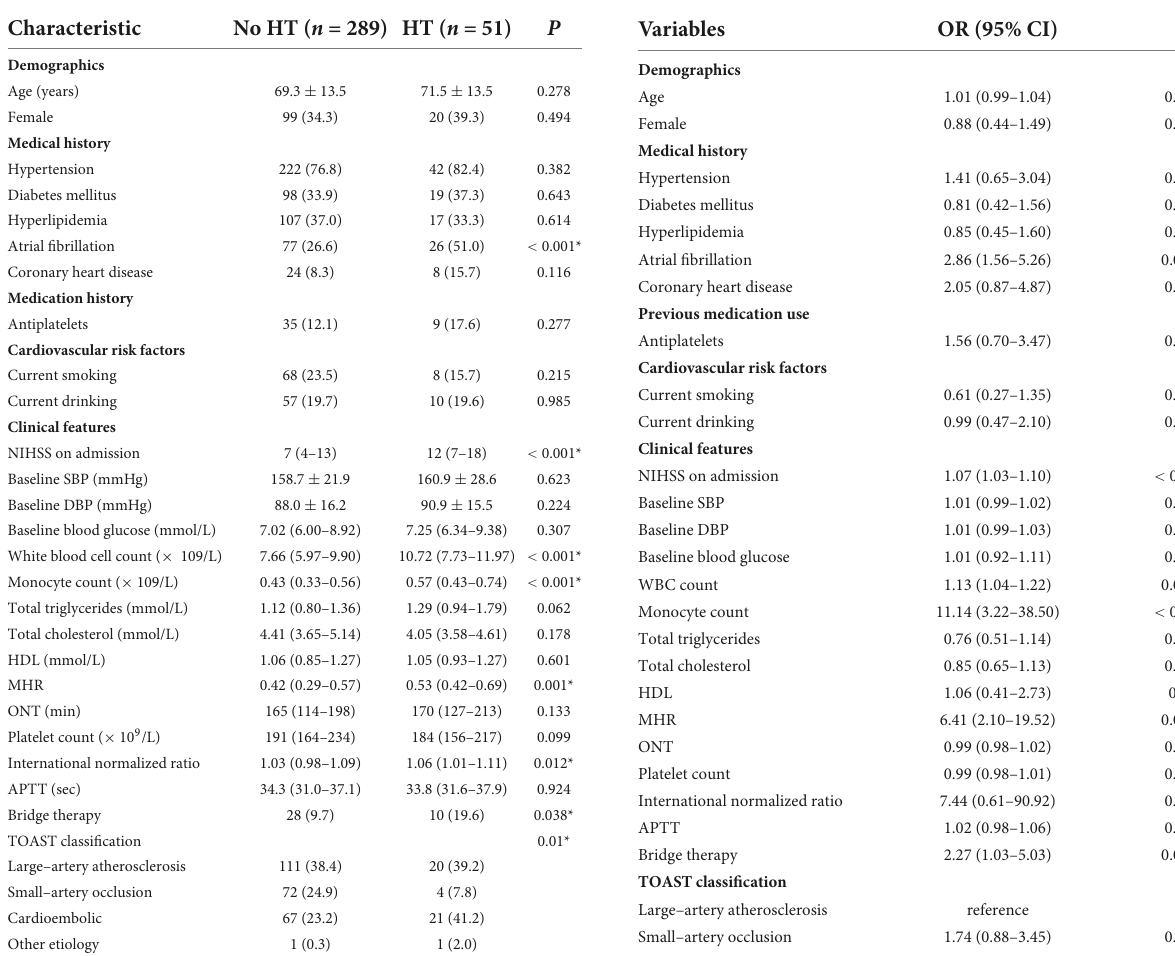
TABLE 3 Univariate logistic regression model for risk factors with hemorrhagic transformation